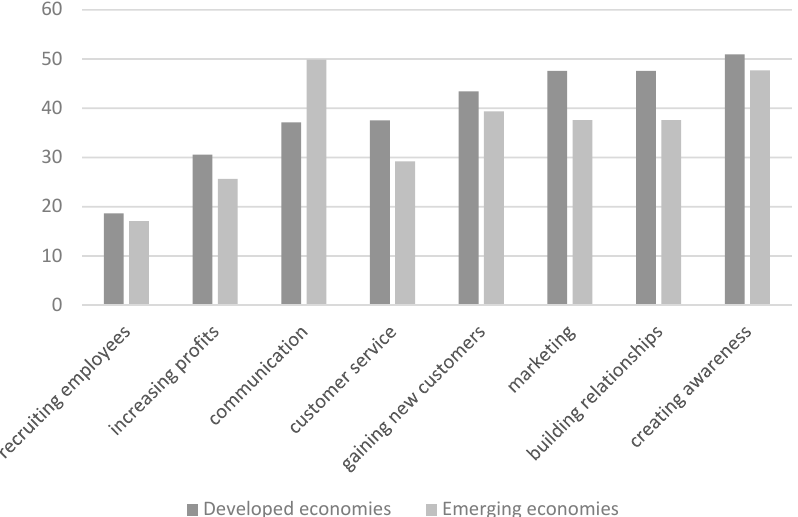
Figure 7. Awareness of technology benefits in different fields .